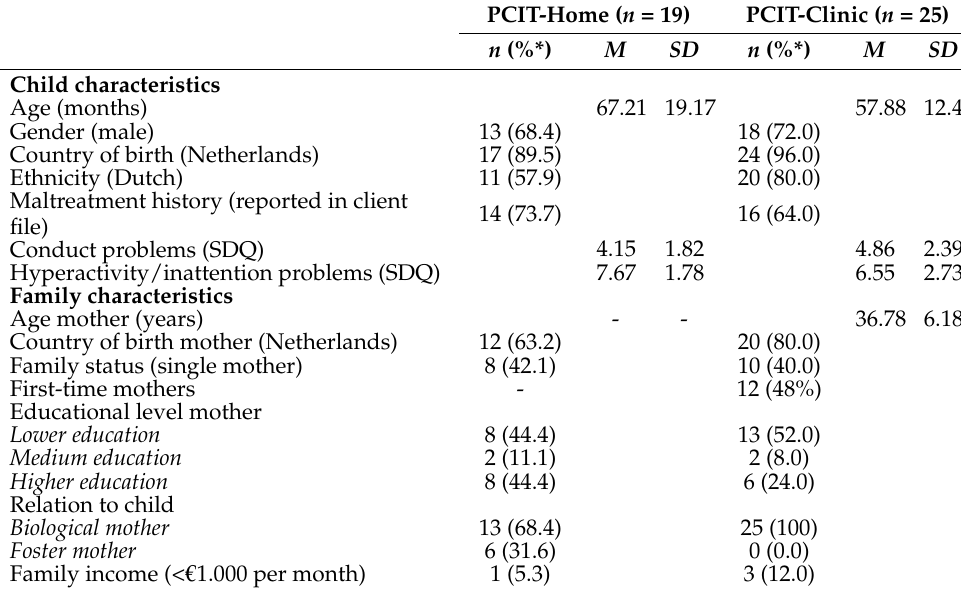
Table 1. Demographic information for the PCIT-Home and PCIT-Clinic